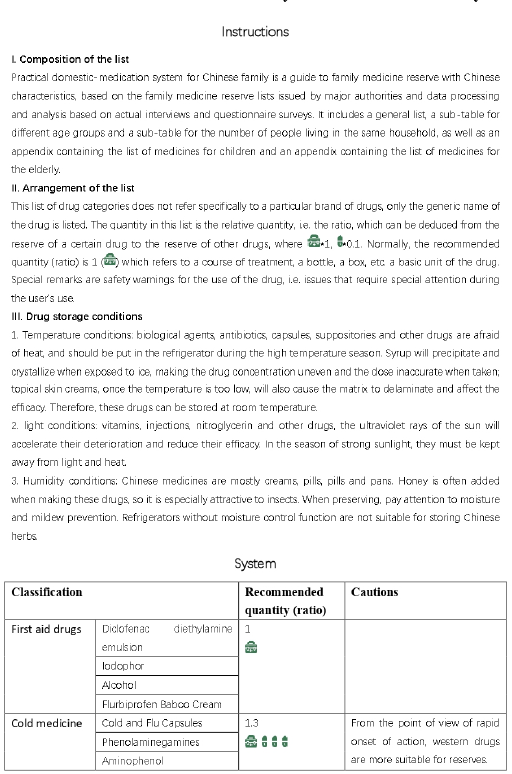
Figure 17. Final practical domestic-medication system.